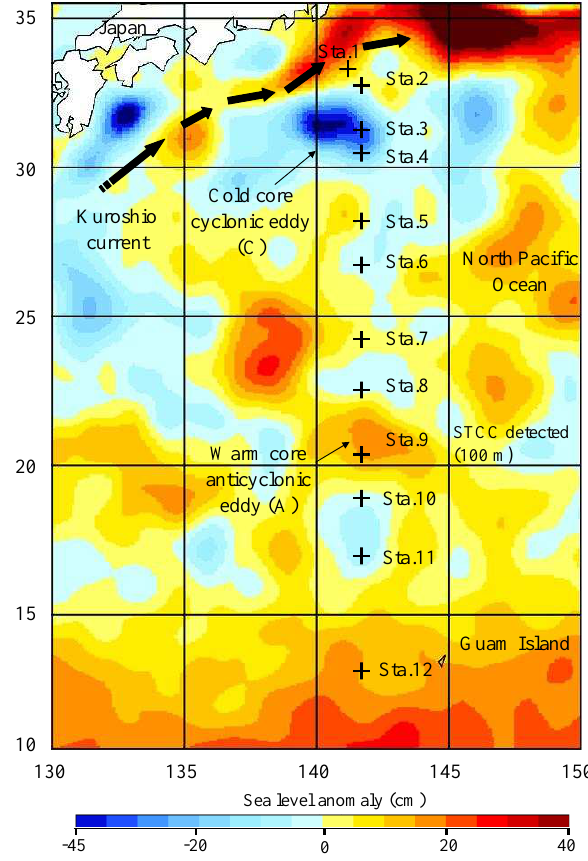
Fig. 1. Map of the sea level anomaly (cm) in the west part of the North Pacific subtropical gyre. Thick black arrows display the di- rection of the Kuroshio Current. Black crosses are the location of the sampling stations during the